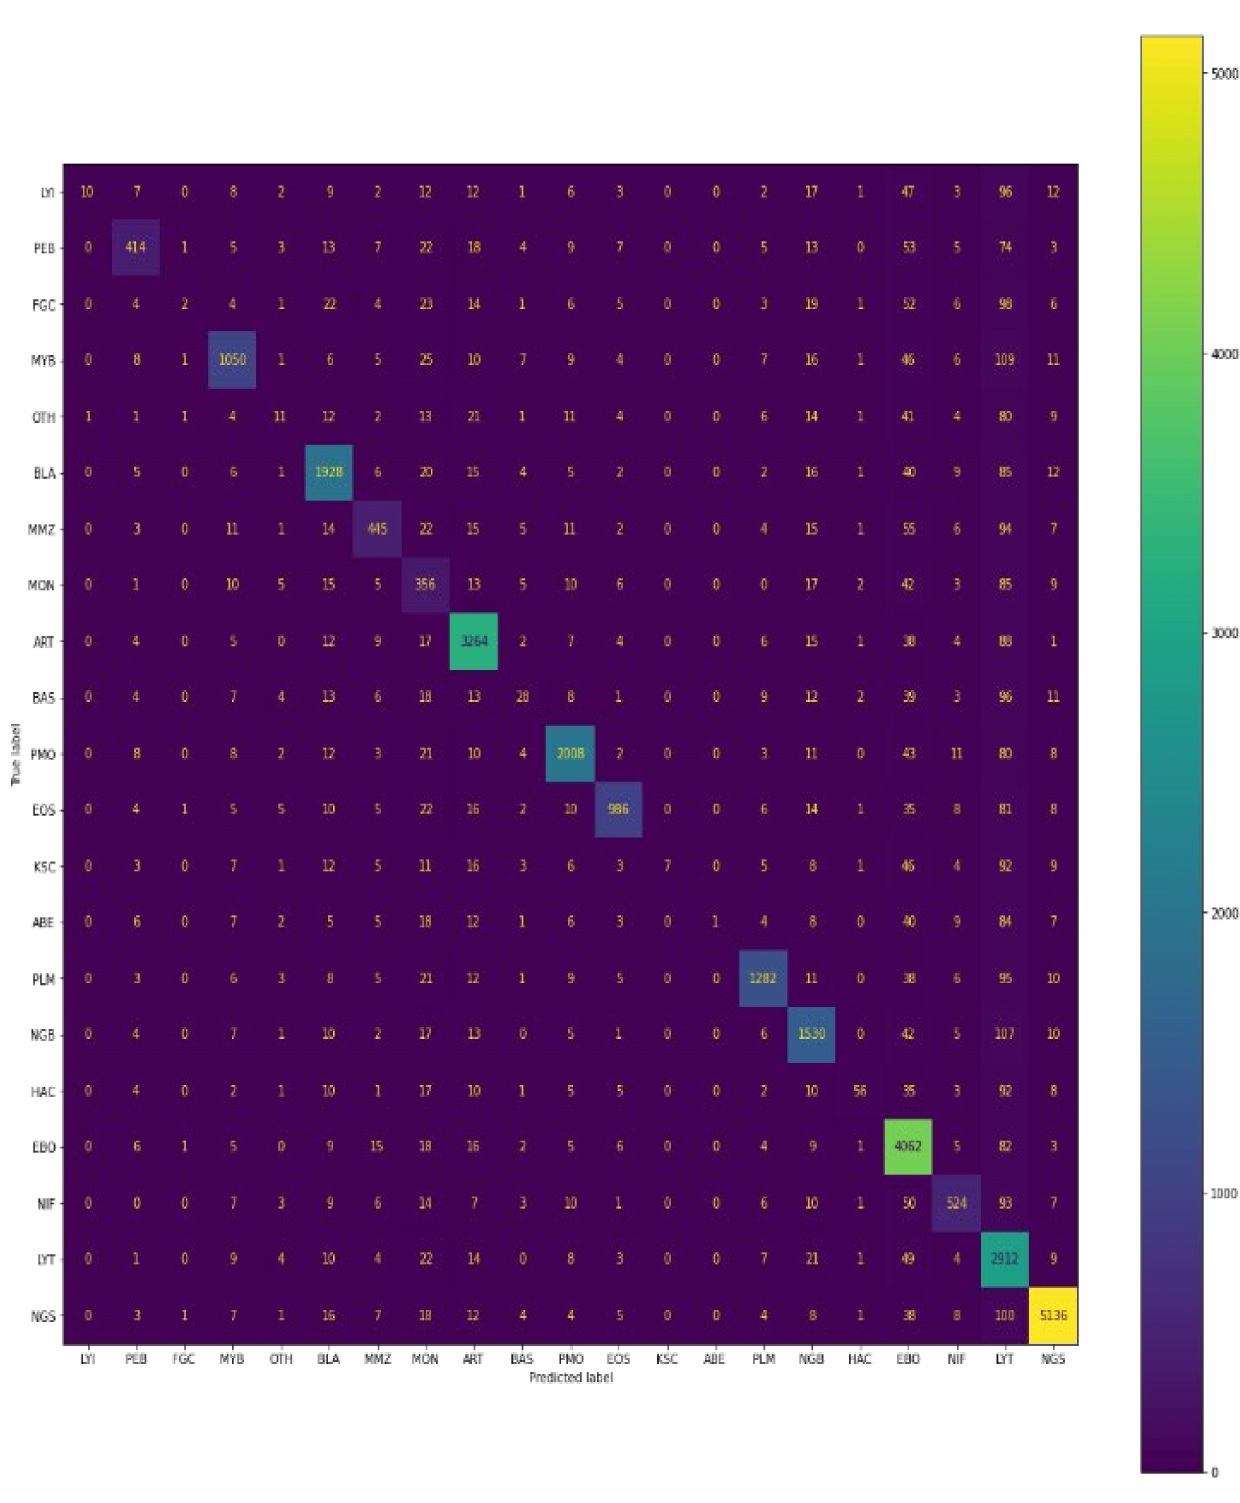
Figure 16. Confusion matrix of predictions generated by Siamese